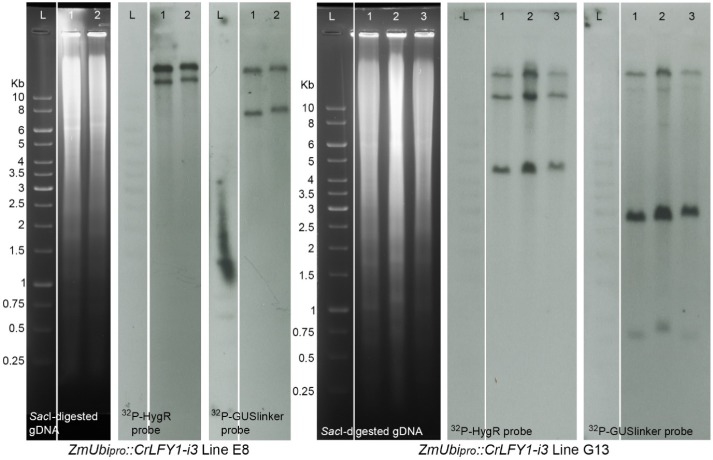
Gel blot analysis of ZmUbipro::CrLFY1-i3 T1 transgenic lines.ZmUbipro::CrLFY1-i3 lines E8 and G13 were regenerated from two separate bombardments and so are necessarily independent of one another. Genomic DNA was extracted from four T1 sporophytes (arising from the free fertilization of T1 gametophytes) within each line, digested with SpeI and separated on an electrophoresis gel. Gel blot analysis of both constructs was performed with probes hybridizing either to the GUS linker of the RNAi hairpin or to the hygromycin resistance (HygR) CDS (Figure 6—figure supplement 2). For each full-length ZmUbipro::CrLFY1-i3 T-DNA insertion present in the genome a single insert is predicted to result in unlinked hybridization fragments with minimum sizes of ~1 kb (HygR) or ~3.6 kb (GUS linker). Based on the hybridization fragments obtained, line E8 carries two full-length insertions of the CrLFY1 RNAi cassette and line G13 carries two full-length insertions plus two additional partial insertions.